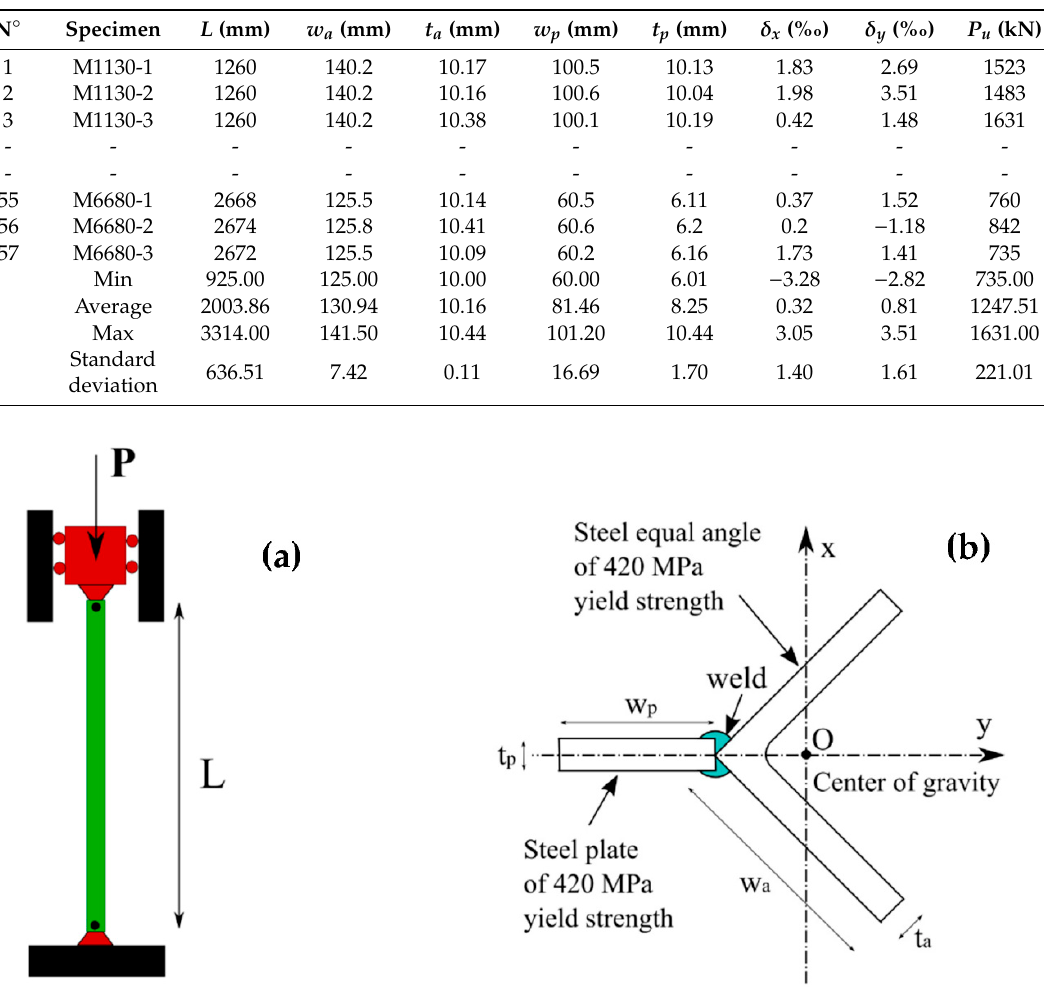
Figure 5. Configuration of columns: ( a ) pinned-pinned column under axial loading and ( b ) geometrical parameters of Y-section.